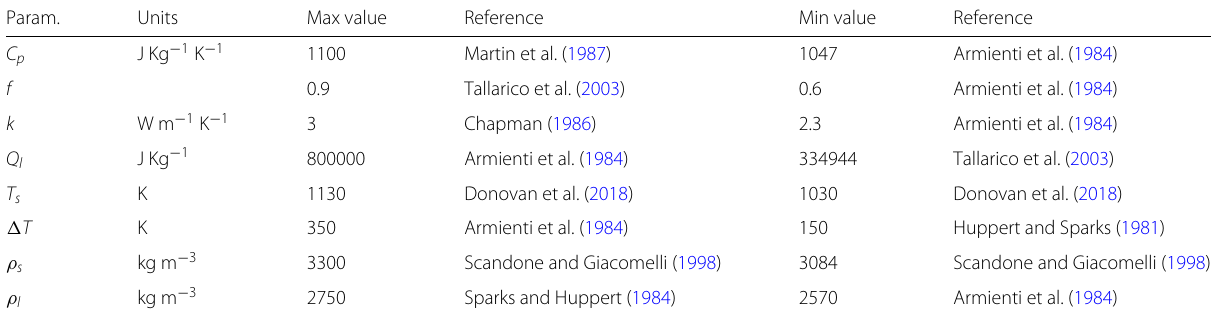
Table 1 Example minimum and maximum values for the thermal characteristics of a magmachamberusedtocalculatethermalcontraction Param.